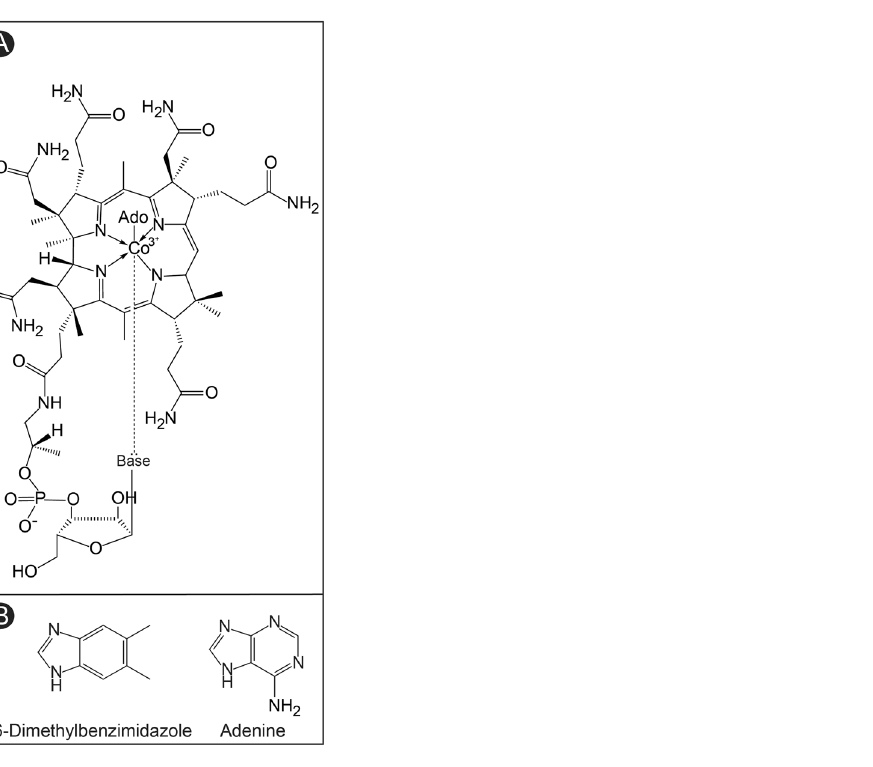
Figure 1. Structure of adenosylcobalamin (AdoCbl), and pseudo-adenosylcobalamin (psAdoCbl). ( A ) General structure of an adenosylcobamide, where ‘Base’ refers to diverse nitrogenous nucleobases found in cobamides. Only nitrogenous nucleobases can form a coordination bond (dashed line) with the cobalt ion of the tetrapyrrole ring. In some cases, the nucleobase can be either phenol or p- cresol, which cannot coordinate with the cobalt ion. ( B ) 5,6-Dimethylbenzimidazole (DMB) is the nucleobase found in cobalamin, while adenine (Ade) is the nucleobase found in pseudocobalamin (psCbl).